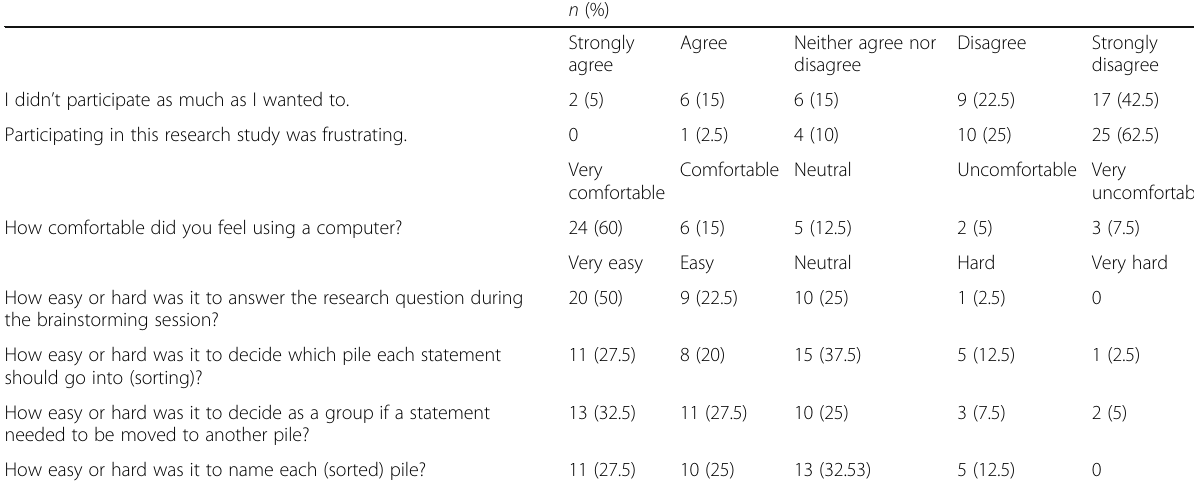
Table 3 Process